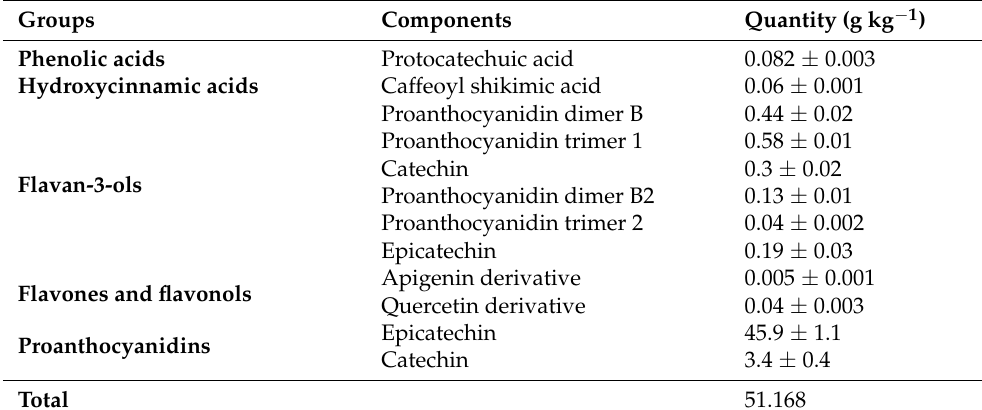
Table 1. Concentrations (mean ± SD) of the key flavonoids and phenolic substances found in the date seed extract before and after